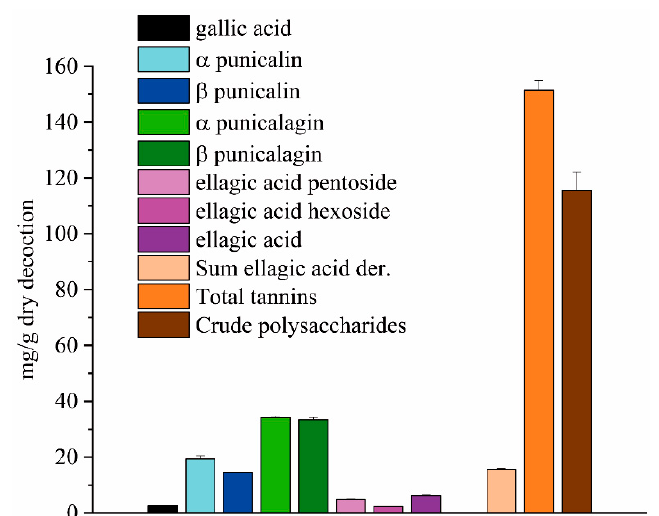
Figure 1. Composition of the dry decoction in terms of phenolic constituents and crude polysaccharides. Distribution of the phenolic compounds, total phenolic content, and crude polysaccharide amount. The data are expressed as a mean of a triplicate, as mg/g dry decoction.